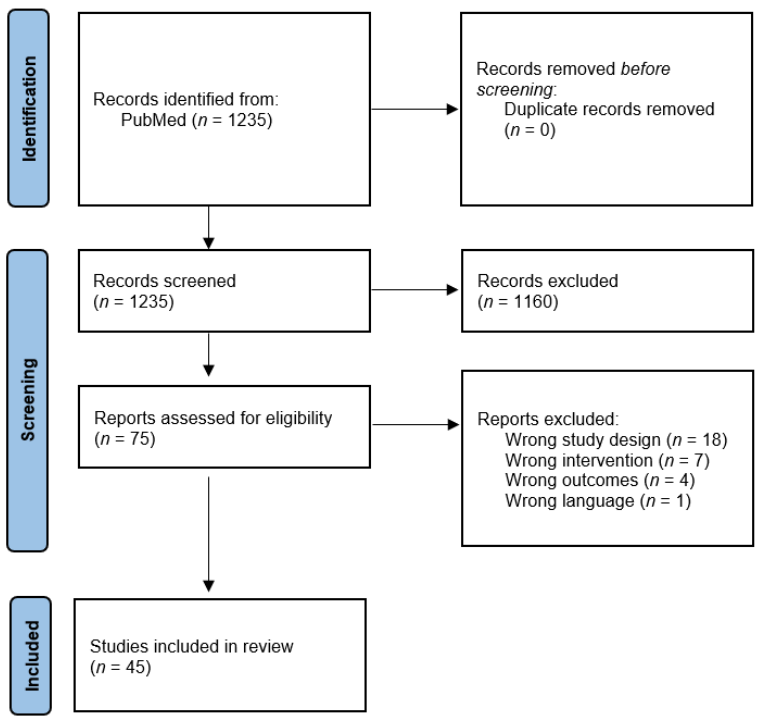
Figure 2. Flow diagram depicting the process of article identification, screening, and inclusion according to Preferred Reporting Items for Systematic Reviews and Meta-Analyses (PRISMA) guidelines. Both preclinical and clinical studies were included in the same article screening process.